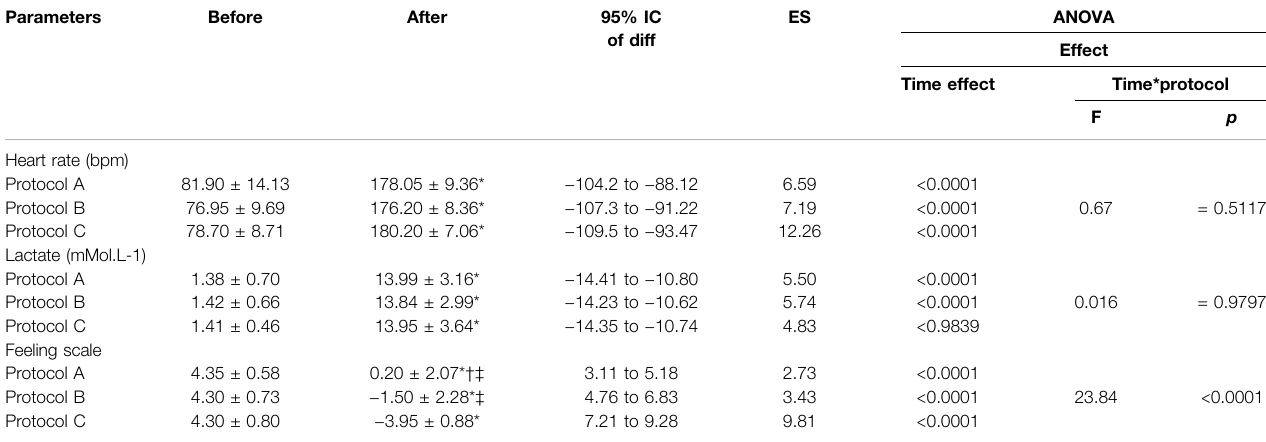
TABLE 1 | Absolute values of heart rate and lactate concentration according to exercise protocol. Parameters